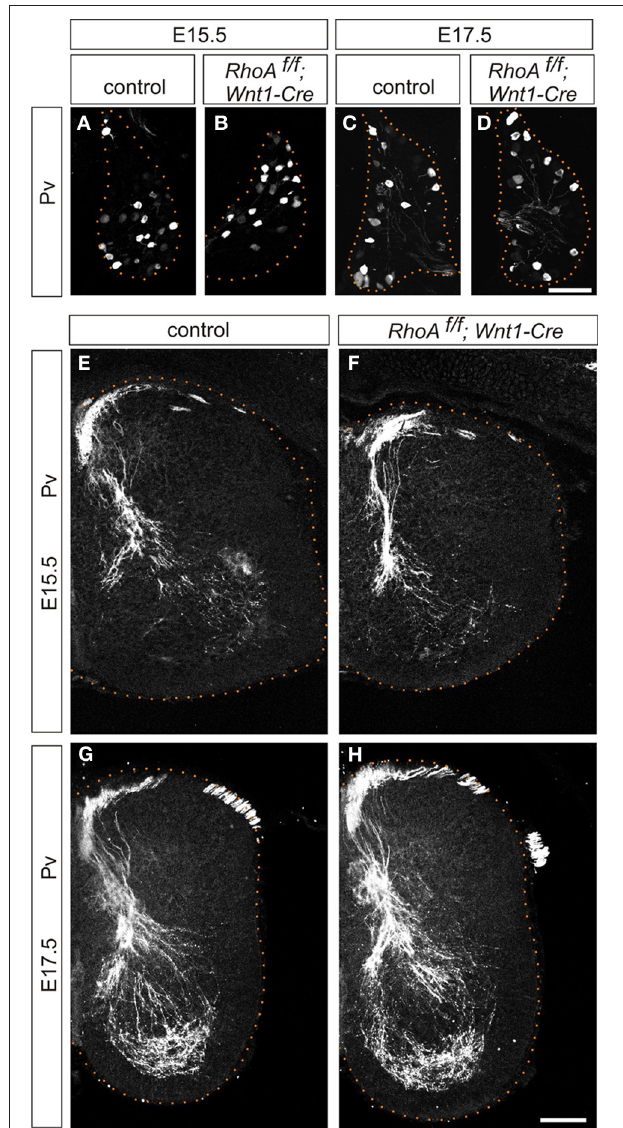
FIGURE 4 | Proprioceptive sensory neurons and proprioceptive axonal projections in the spinal cord of RhoA f / f ; Wnt1-Cre embryos. (A–D) Pv + proprioceptive sensory neurons in DRGs from control and RhoA f / f ; Wnt1-Cre embryos at E15.5 and E17.5. (E–H) Pv + proprioceptive axonal projections in the spinal cord of control and RhoA f / f ; Wnt1-Cre embryos at E15.5 and E17.5. Scale bars, 100 µ